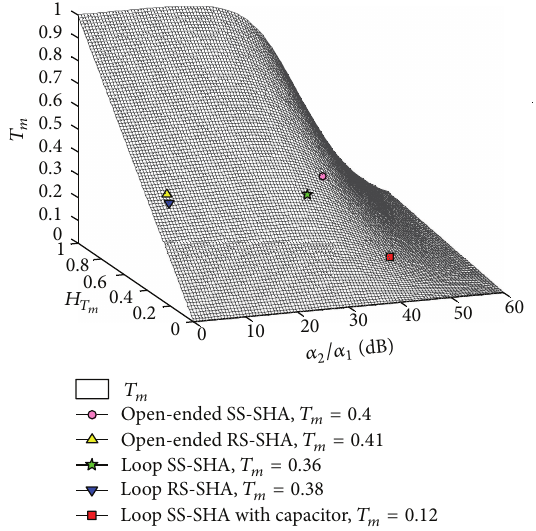
Figure 9: 𝑇 𝑚 versus radiation efficiency factor and mode mismatch /𝛼 𝛼 2 1 for CARS-SHA transmitter.